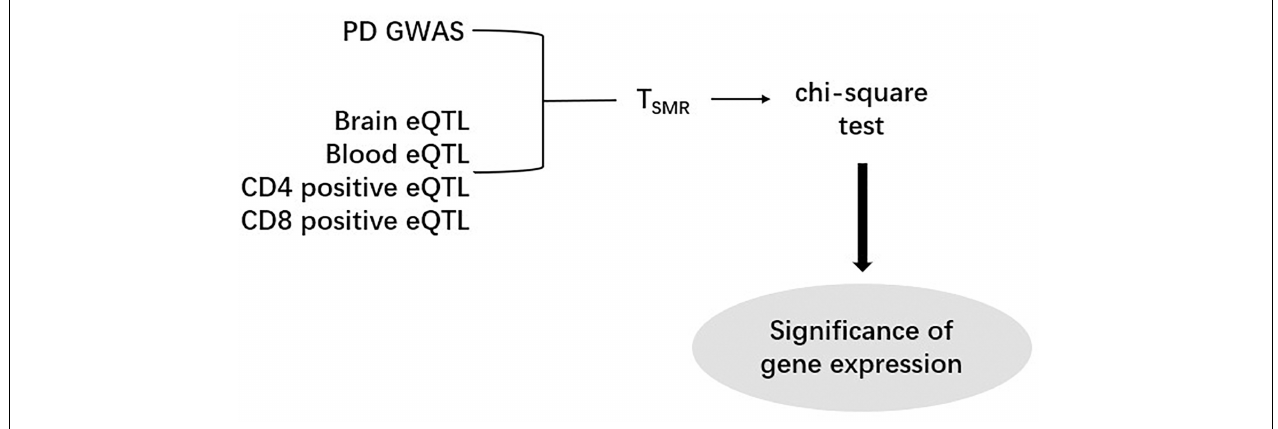
FIGURE 1 | The Summary data-based Mendelian Randomization (SMR) analysis flow chart. One PD GWAS was integrated with each of eQTL data. After calculating T SMR and chi-square test, the significance of gene expression were discovered.